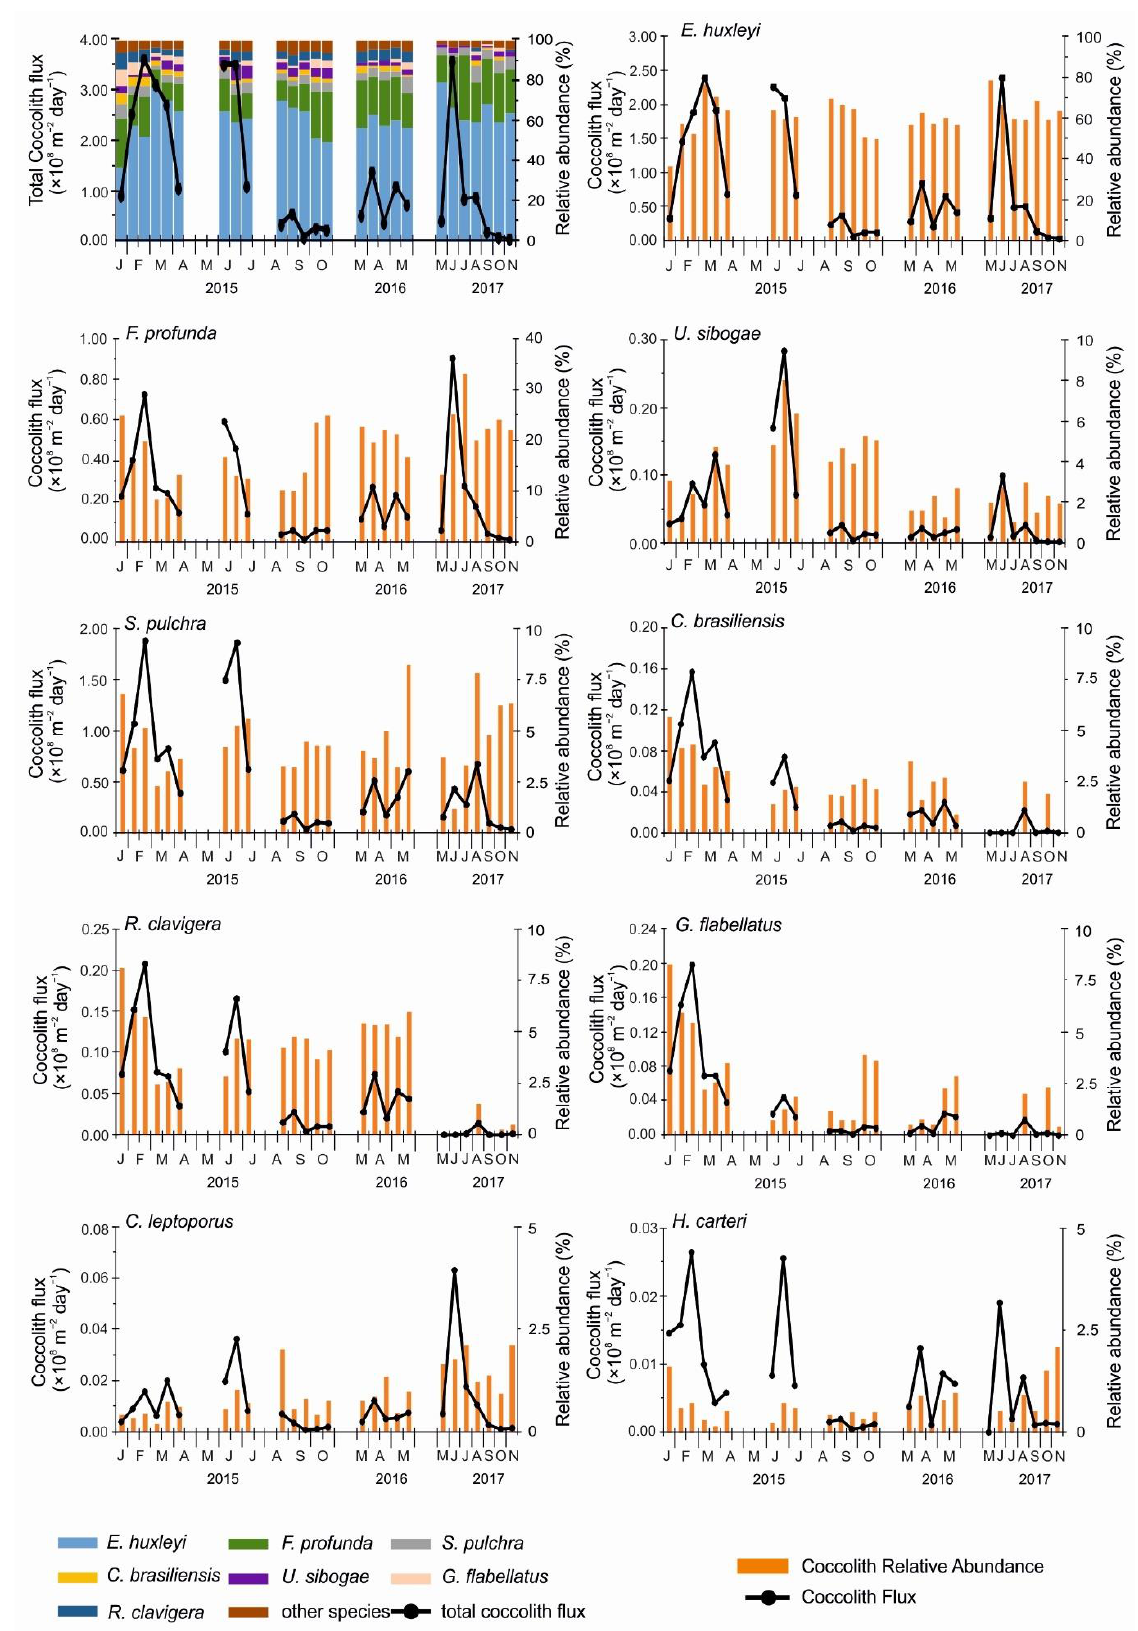
Figure 3. Total coccolith flux and major species coccolith fluxes and relative abundances recorded at 4300 m at Nestor site, SE Ionian Sea.